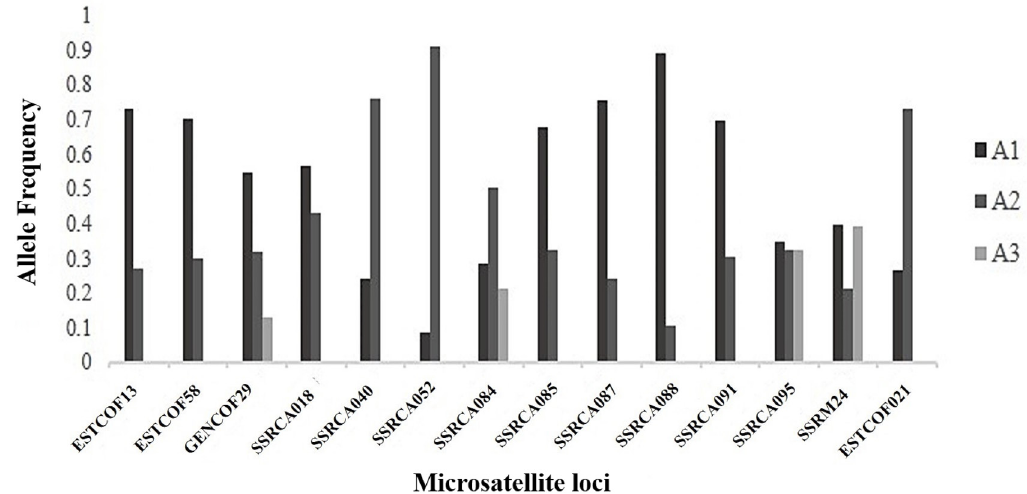
Figure 1. Percentage of the allele frequencies obtained in each of the 14 evaluated loci, where A1, A2 and A3 are the alleles presented by each